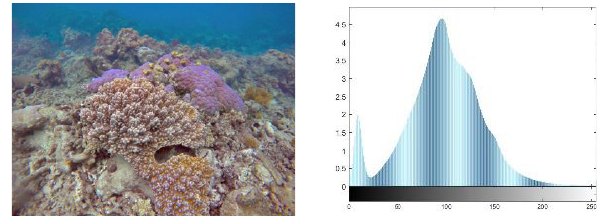
Figure 5. Results of pre-processing on the images and the histograms, i.e. saturation enhancement (S), haze reduction (RH), Rayleigh distribution adaptation (RD), global image equalization (GE), and sharpening (SH). 1 st row : initial image; 2 nd row : S; 3 rd row : S – RH; 4 th row : S – RH – RD; 5 th row : S – RH – RD – GE; 6 th row : S – RH – RD – GE – SH.